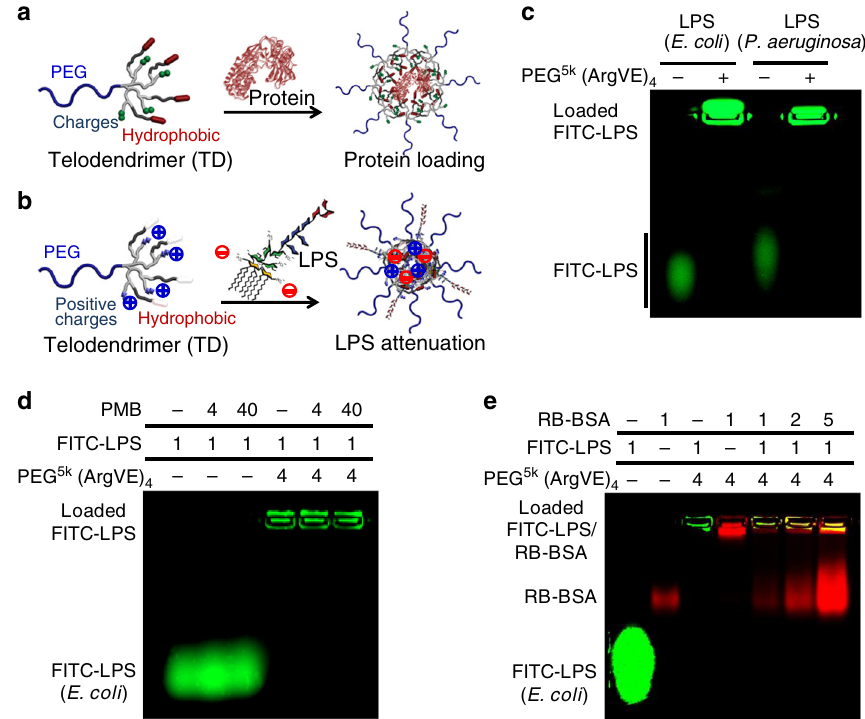
Fig. 1 Protein and LPS binding in telodendrimer nanoparticles. Schematic illustration of a protein and b LPS captured by telodendrimer nanoparticles via the combination of charge and hydrophobic interactions. c – e Agarose gel electrophoresis pro fi les reveal the complex formation of the FITC-labled LPS with telodendrimer PEG 5k (ArgVE) 4 , as indicated by the lost mobility in migration (repeated independently a minimum of twice). c LPS originated from both E. coli and P. aeruginosa can be captured ef fi ciently by the telodendrimer PEG 5k (ArgVE) 4 . d PMB form less-stable complex with LPS in electrophoresis, which was also unable to dissociate LPS – PEG 5k (ArgVE) 4 nanocomplex with 40-fold excess in mass ratio. e The stability of LPS – PEG 5k (ArgVE) 4 nanocomplex was also observed to be stable in the presence of serum protein (RB-BSA) at different mass ratios.